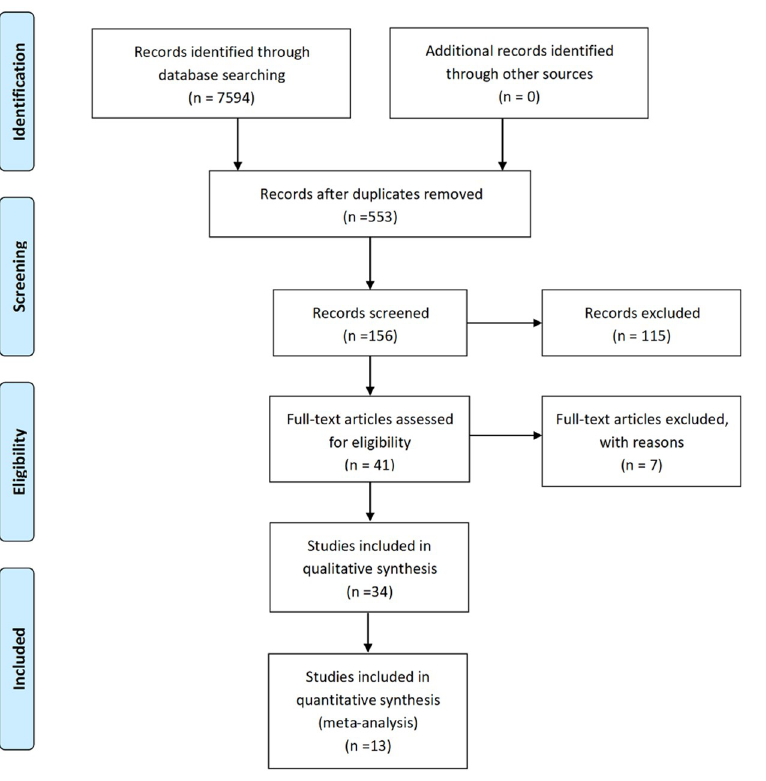
Fig 1. PRISMA flow diagram of the studies selection process